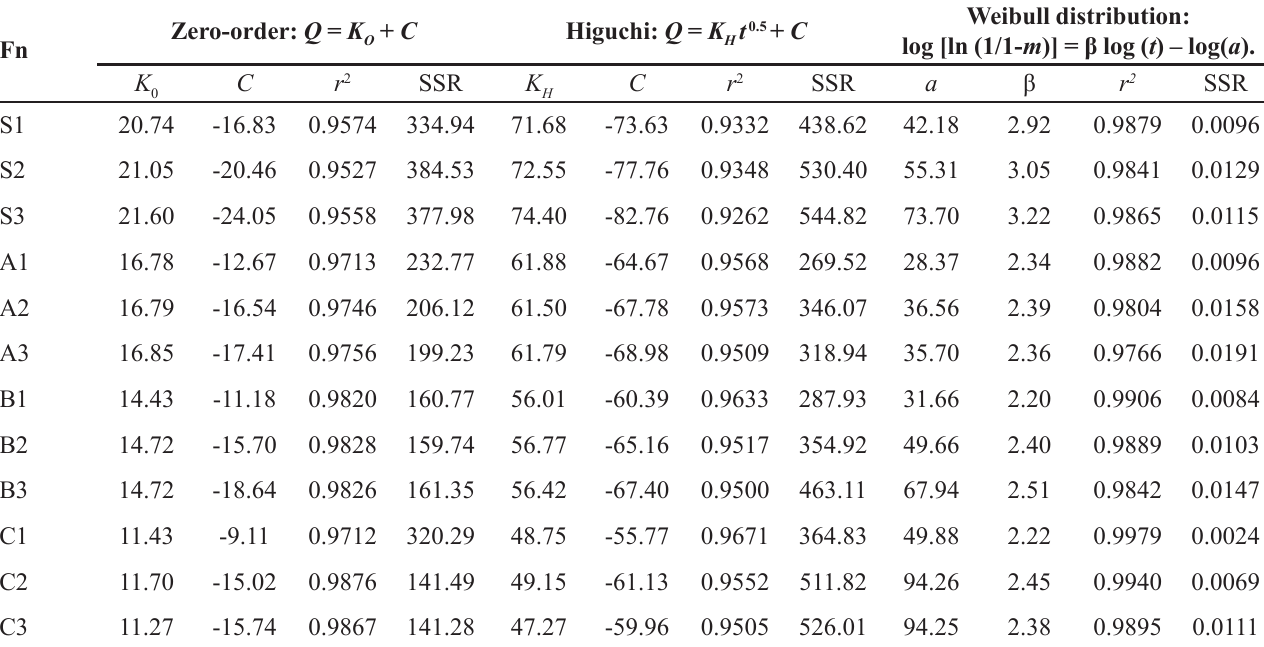
TABLE V - Parameter and correlation coefficients for zero-order equation, Higuchi equation, and Weibull distribution Zero-order: Q = K + O Fn